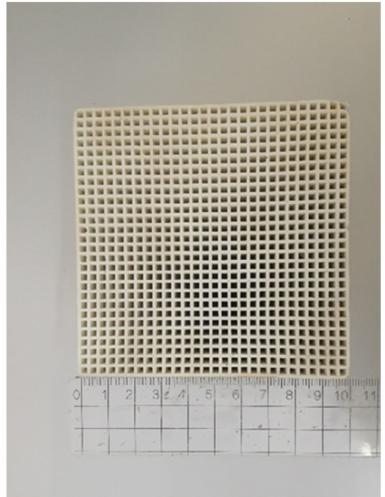
Figure 1. Ceramic honeycomb